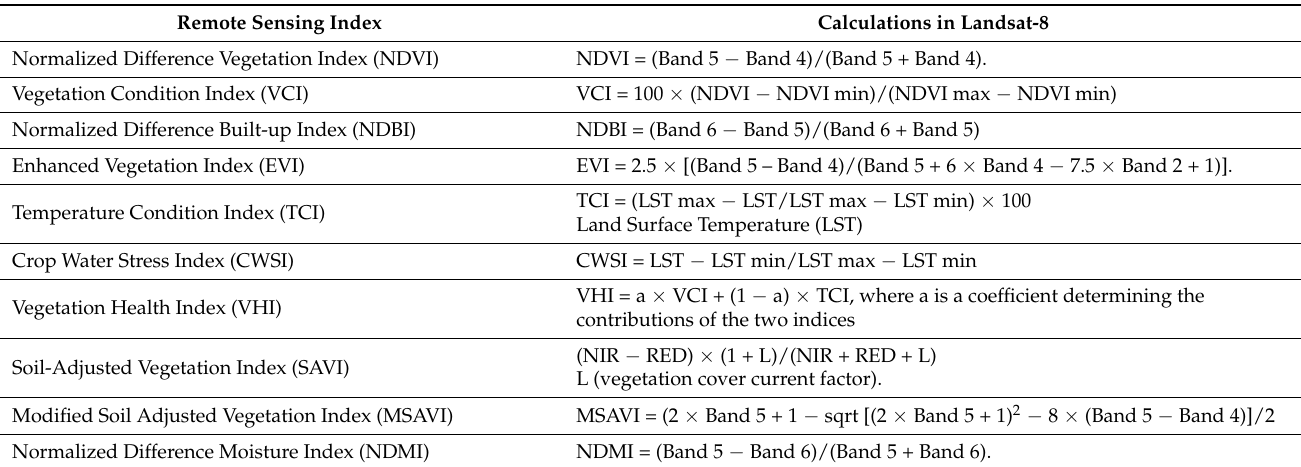
Table 1. Remote Sensing Indices